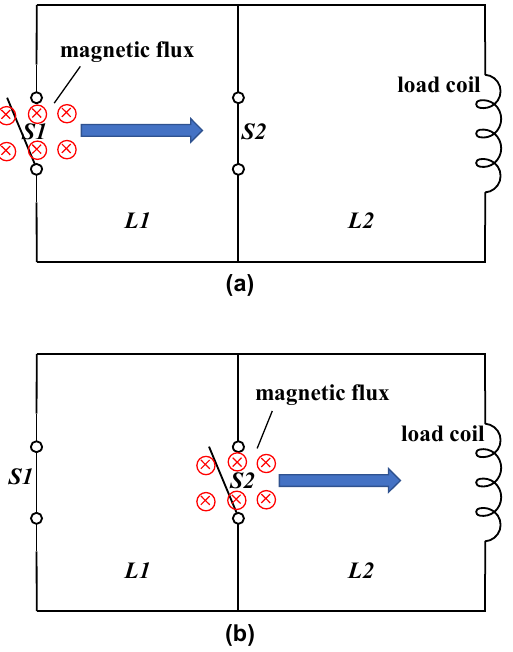
Figure 1. Illustration of flux pumping for LTSCs. Stage for ( a ) bringing flux into loop L1, ( b ) transferring flux into loop L2.